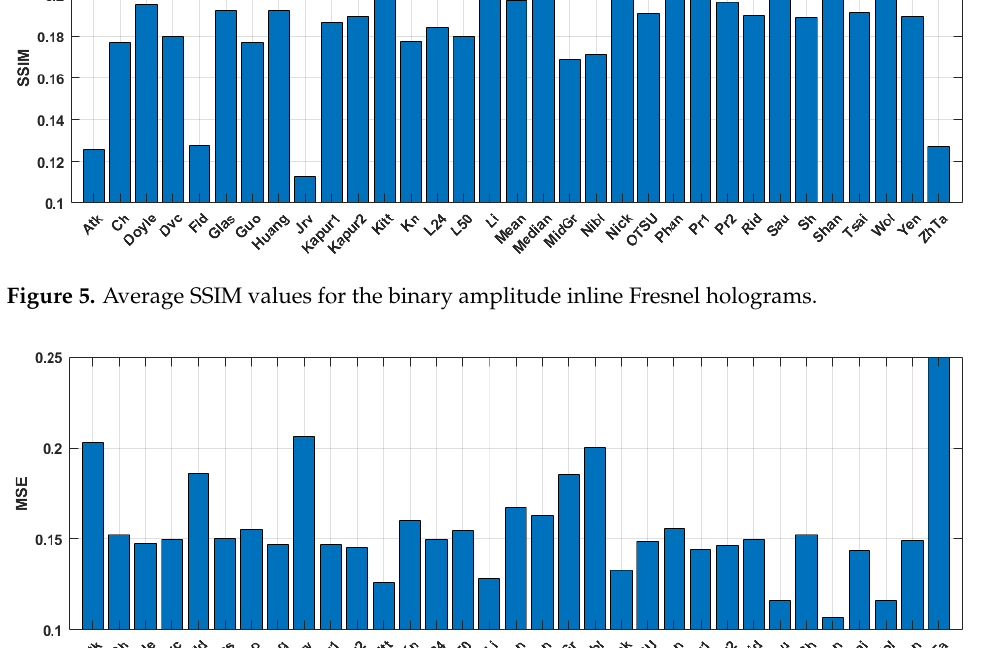
Figure 6. Average MSE values for the binary amplitude inline Fresnel holograms.